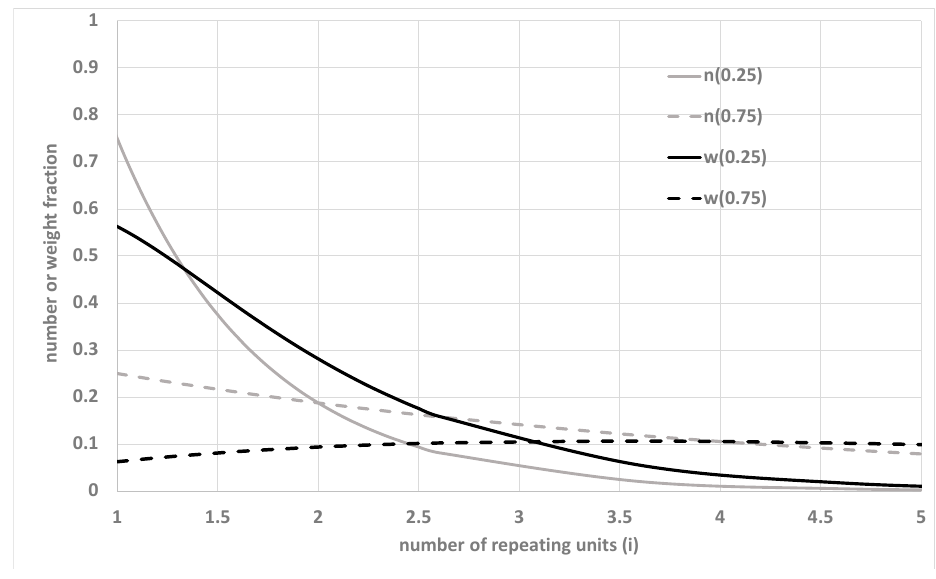
Figure 1. Number (n) and weight (w) distributions at a conversion equal to 0.25 and 0.75.